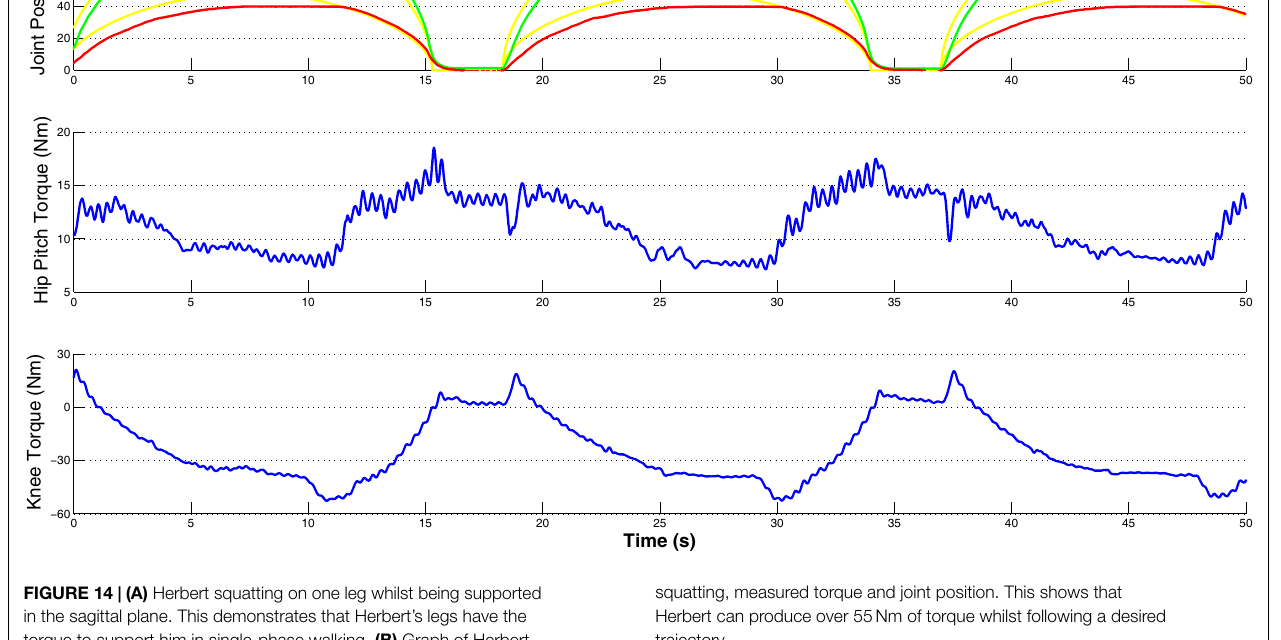
FIGURE 14 | (A) Herbert squatting on one leg whilst being supported in the sagittal plane. This demonstrates that Herbert’s legs have the torque to support him in single-phase walking. (B) Graph of Herbert